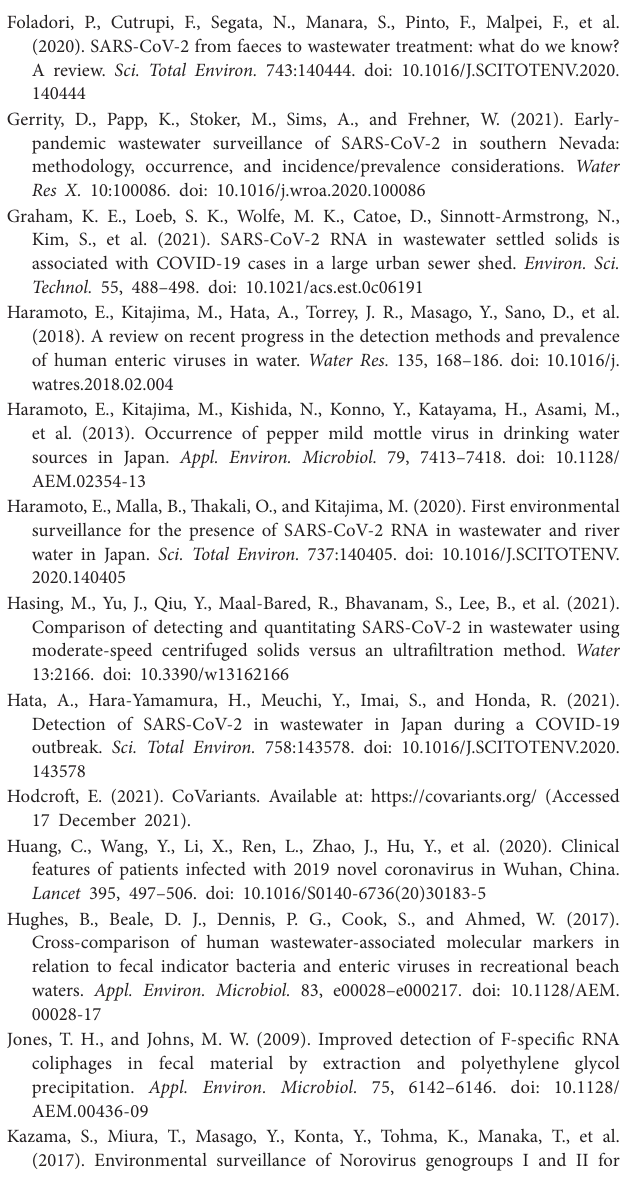
Supplementary Figure S1 | Detection limit of SARS-CoV-2 RNA using RT- qPCR. Each copy of the standard SARS-CoV-2 RNA (Ct value) was confirmed using RT-qPCR measurement. The slope, intercept, and coefficient of determination ( R 2 ) values were calculated using linear regression. Supplementary Figure S2 | SARS-CoV-2 RNA copy number in the PEG- precipitated or unconcentrated sample and COVID-19 case numbers. The SARS- CoV-2 copy numbers in the liquid fraction concentrated using PEG precipitation (A,B) or unconcentrated raw sample (C,D) from WWTP-A ( A,C ; orange circles) and WWTP-B ( B,D ; blue squares) are plotted. The number of new COVID-19 cases per day in WWTP basin is indicated by the gray bars, and the seven-day moving average is indicated by the red line. Supplementary Figure S3 | The amount of rainfall and SARS-CoV-2 RNA copy number in the solid fraction. The SARS-CoV-2 RNA copy number in the solid fraction from WWTP-A ( A,C ; orange circles) and WWTP-B ( B,D ; blue squares) are plotted. The amount of rainfall in each WWTPs is indicated by the purple bars (A,B) and the amount of influent flow is indicated by the black line (C,D)